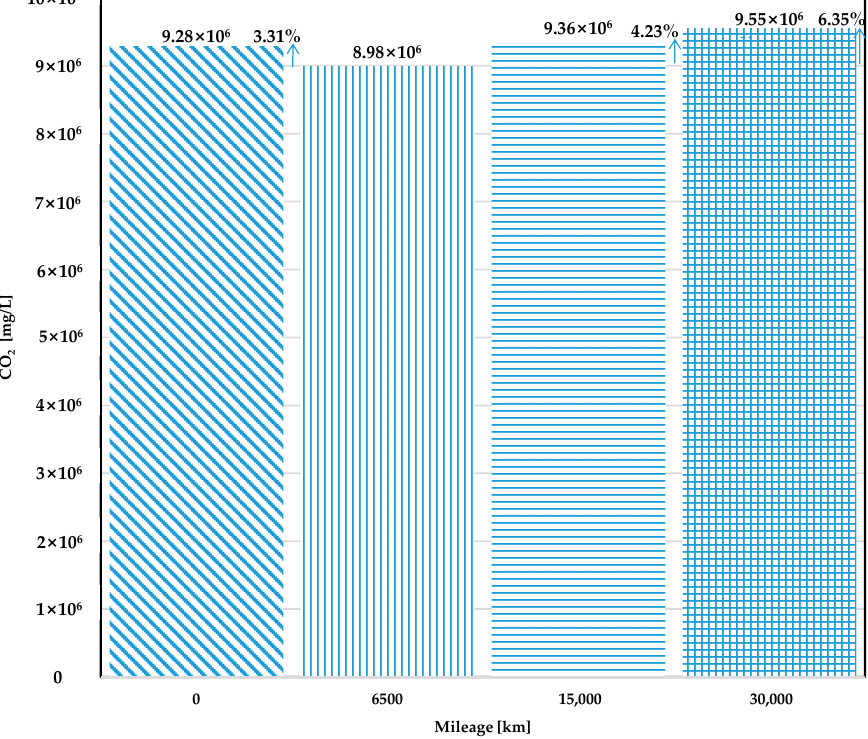
Figure 8. Total CO 2 emissions measured during the US06 driving cycle according to each mileage .